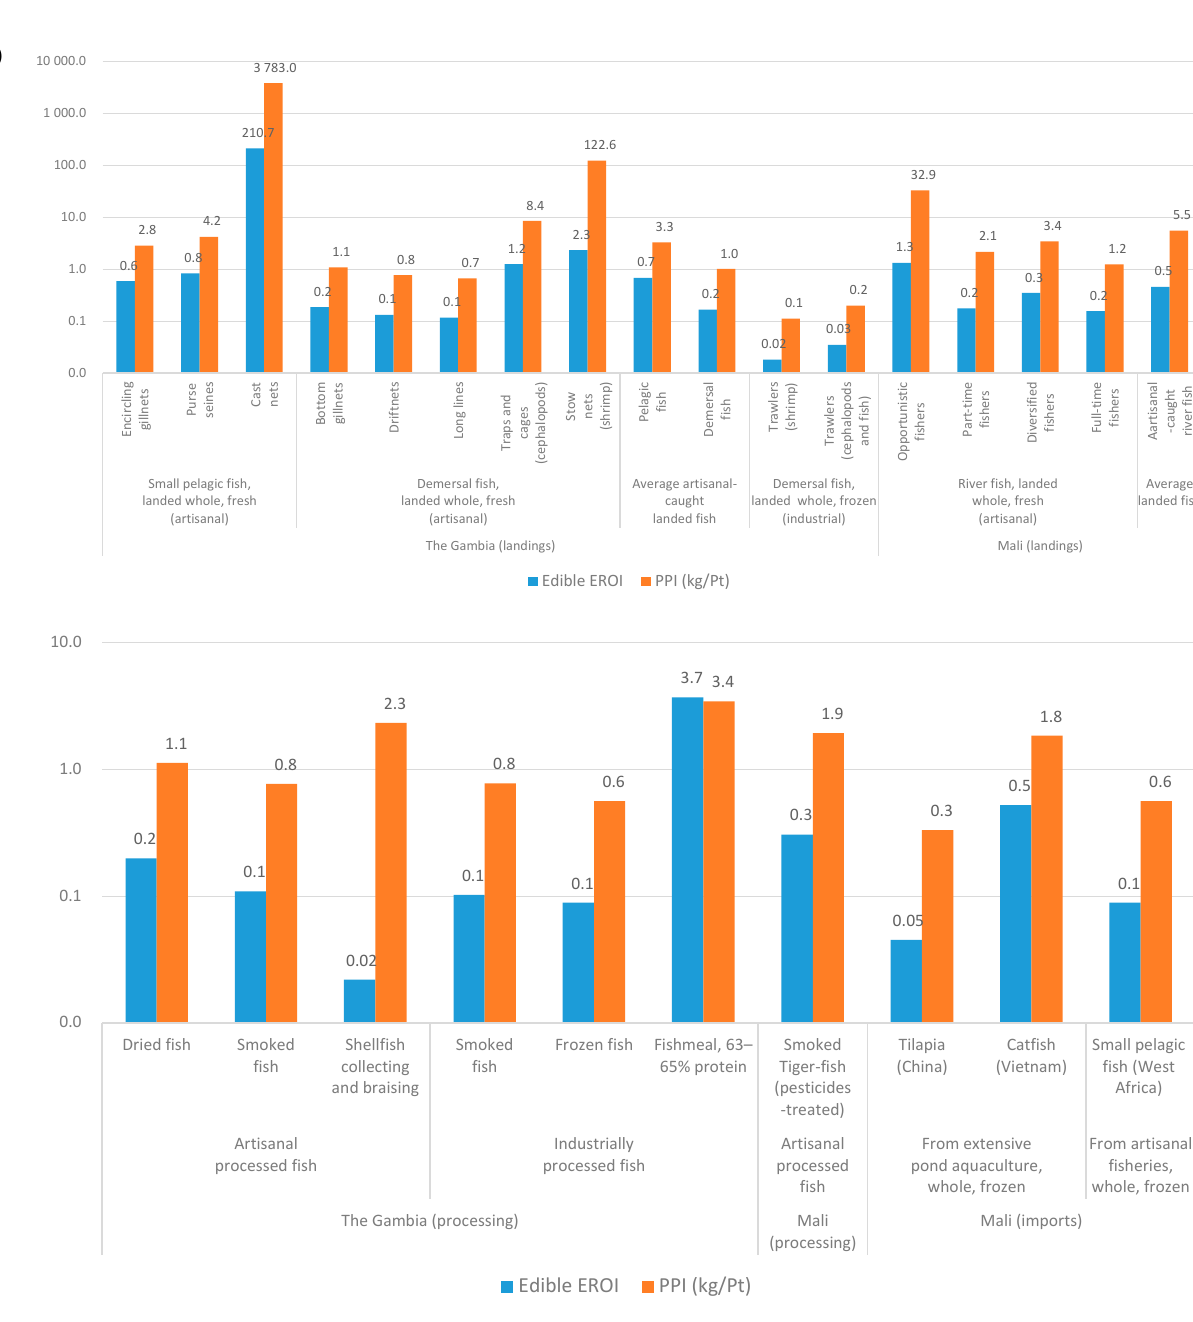
Figure 6. Edible energy return on the investment (EROI) and protein-per-impact (PPI) of Gambian and Malian fish products: ( a ) fresh fish and ( b ) processed fish.